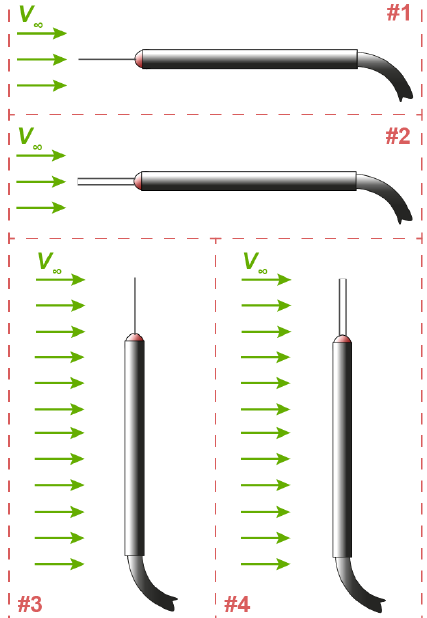
Fig. 4. Sketches presenting four different orientations of the SWHWA probe applied during